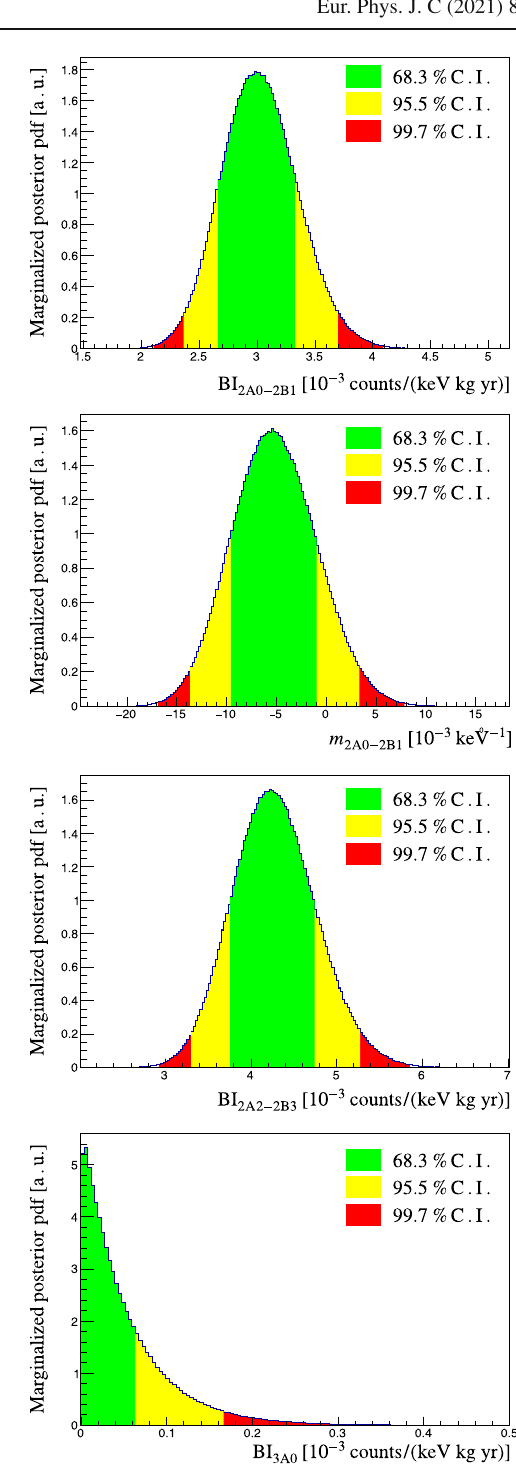
Fig. 6 Marginalized posterior pdf for the background parameters of the 2 νββ model from the combined fit with all systematics. We show the 68 . 3% , 95 . 5% , 99 . 7% smallest C.I. in green, yellow and red respec-